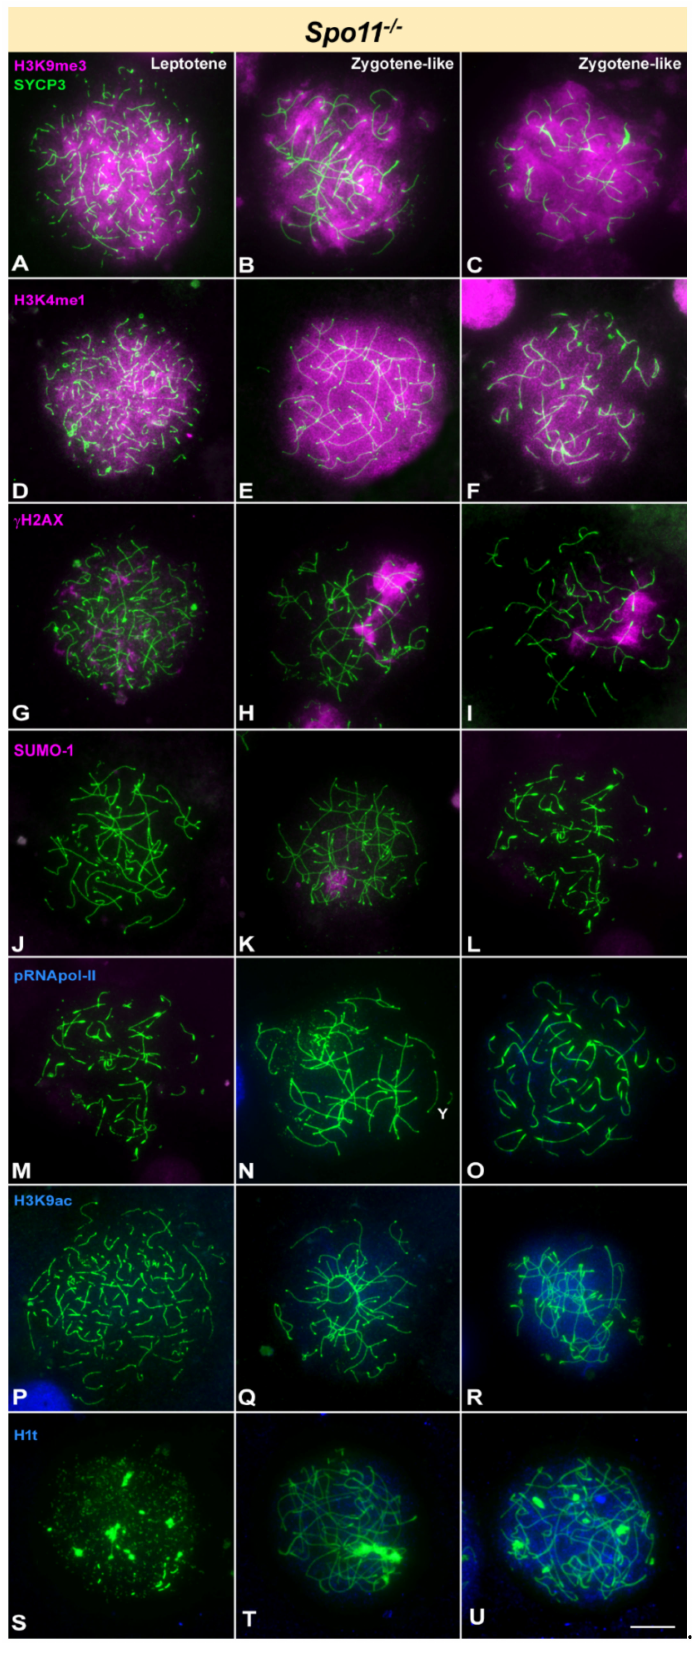
Figure 3. Immunolocalization of SYCP3 (green) and epigenetic markers of silencing (pink) or transcription activation (blue) in Spo11 knockout